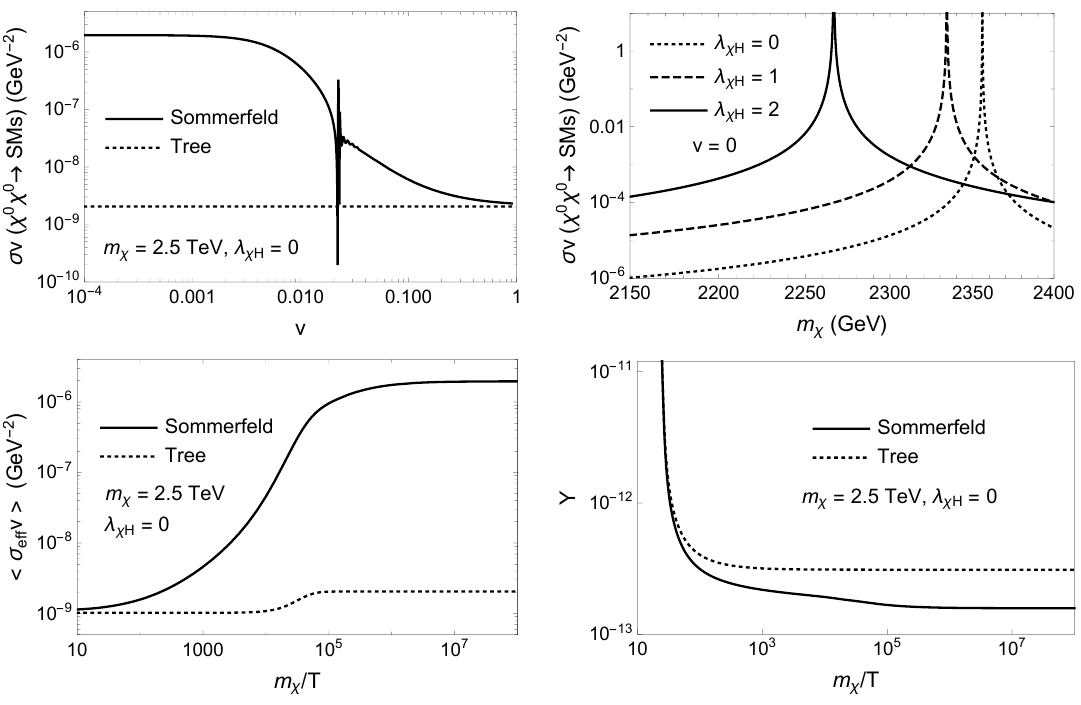
Figure 2 . The total annihilation cross section of the dark matter into SM particles as a function of the relative velocity with m χ = 2 . 5 TeV & λ χH = 0 (top-left), the same cross section as a function of m χ with v = 0 & λ χH = 0, 1, 2 (top-right), the thermally averaged effective annihilation cross section as a function of the inverse temperature with m χ = 2 . 5 TeV & λ χH = 0 (bottom- left), and the comoving density as a function of the temperature with m χ = 2 . 5 TeV & λ χH = 0